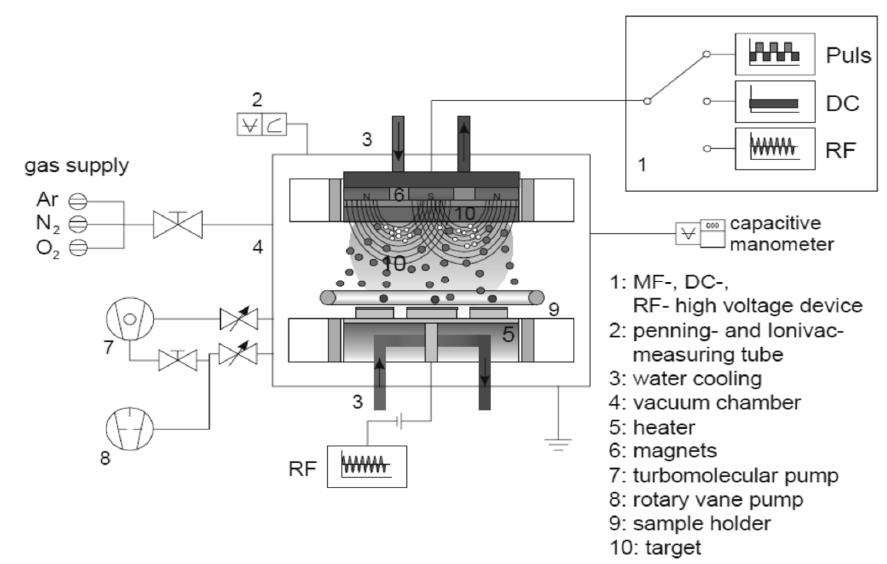
Figure 1. Principle of the reactive radio frequency (RF) magnetron sputtering [33–35].